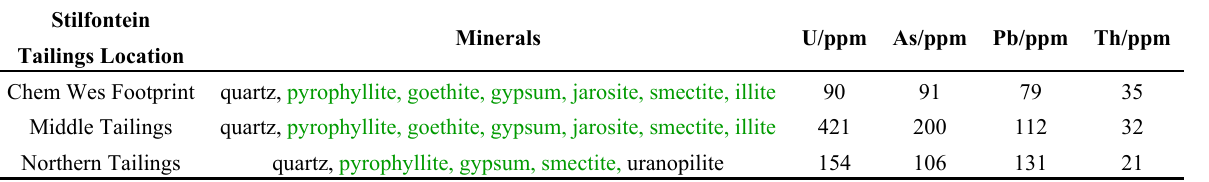
Table 3. Mineralogical data from X-ray diffraction analysis (XRD) of gold mine tailings samples, directly below. Minerals that have been found through MICA analysis of ASD Fieldspec data are highlighted in green. Selected trace elements (in ppm) from gold mine tailings, by X-ray florescence data (XRF) from tailings